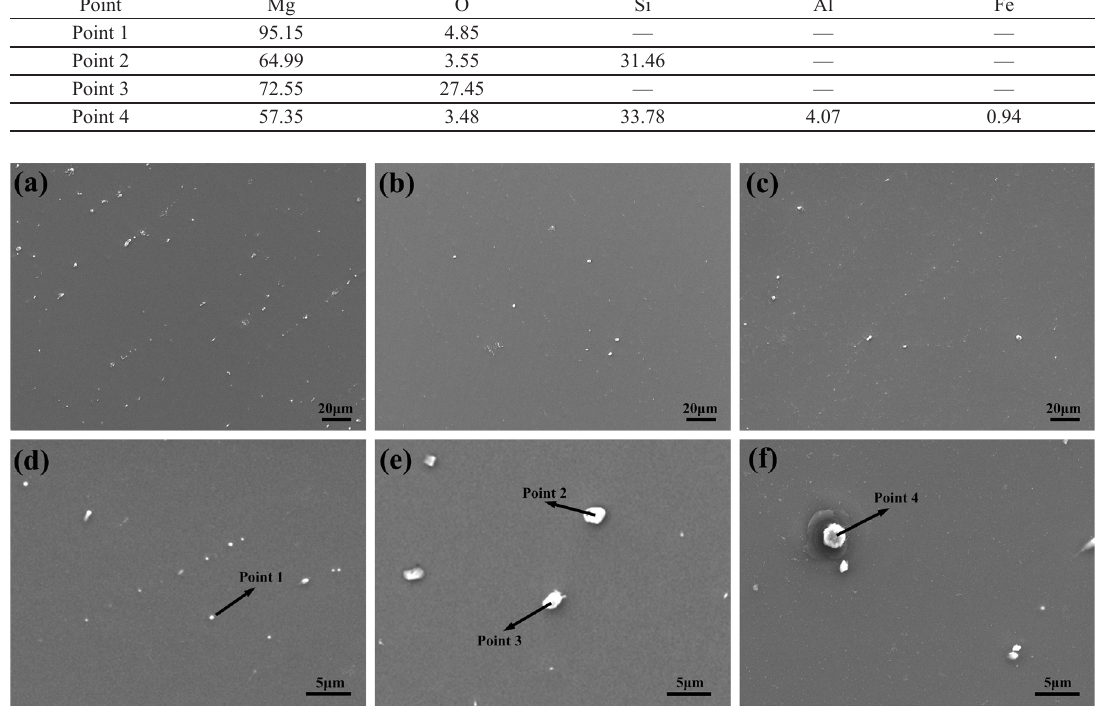
Figure 2. The morphology of the different regions of the casting: (a) (d) top; (b) (e) center; (c) (f) bottom